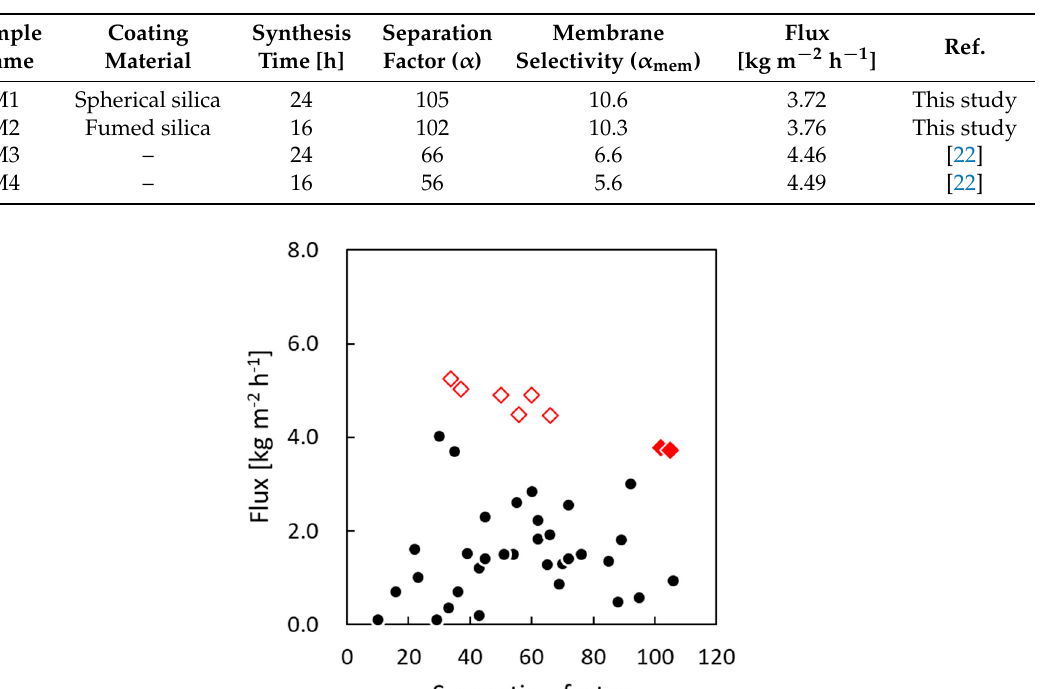
Table 2. PV performances of silicalite-1 membranes prepared under different synthesis conditions using the gel-free SAC method with respect to separation of ethanol/water mixture. Sample.